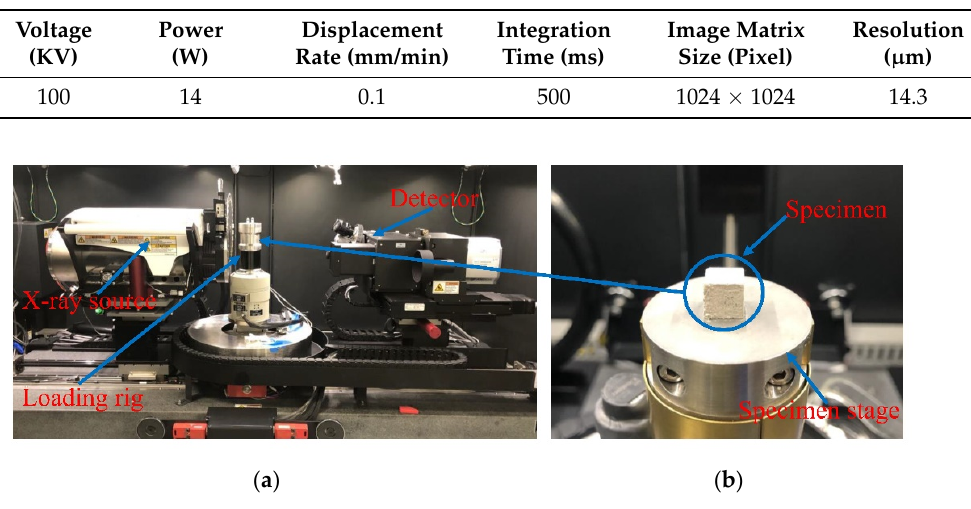
Table 1. Parameters of the X-ray CT test.